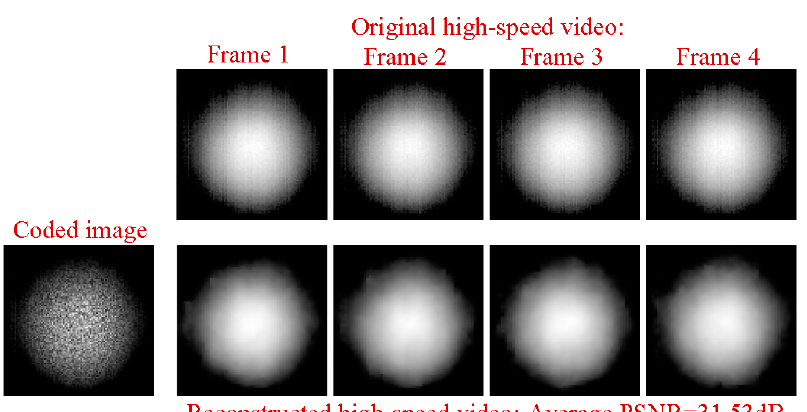
Figure 7. The comparison of the reconstructed high-speed video with the original one at the case of 16 × compression. Top row: the first four frames of the original high-speed video. Bottom row: the corresponding reconstructed video and the coded image. The high-speed video in the bottom row are reconstructed from the coded image.